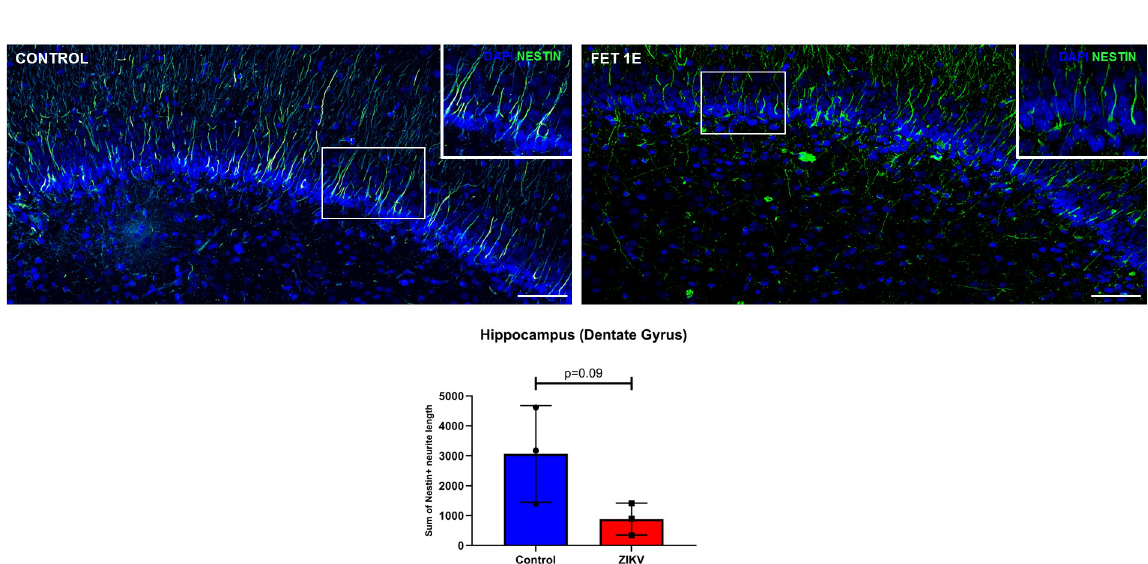
Fig 10. Immunofluorescence (IF) for neural progenitor cell (NPC) marker Nestin in the sub granular zone (SGZ) of the hippocampal dentate gyrus (DG). Control hippocampus show uniform and organized Nestin positive neurite processes of progenitor cells in the DG (box and inset). Hippocampal neurite lengths in the Nestin+ cells were reduced in fetuses from ZIKV inoculated dams with the appearance of non-uniform and disorganized distribution of Nestin+ neuronal processes of progenitor cells along the DG as compared to control hippocampi (inset) (Scale bar = 100 μ m; Error bars depict SD, unpaired t -test, p < 0.05 considered significant).